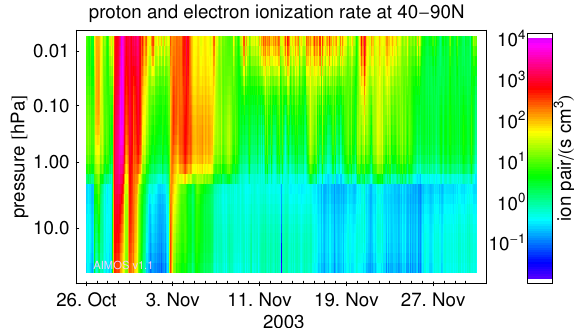
Fig. 5. Temporal evolution of area-weighted averages (40–90 ◦ N) of AIMOS ion pair production rates for protons and electrons dur- ing the period of interest. Electron ionization rate below 1hPa is induced by bremsstrahlung only.